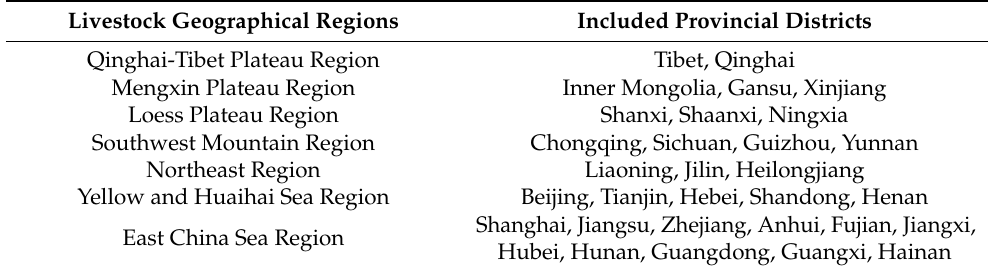
Table A1. Provincial districts included in the livestock geographical regions.